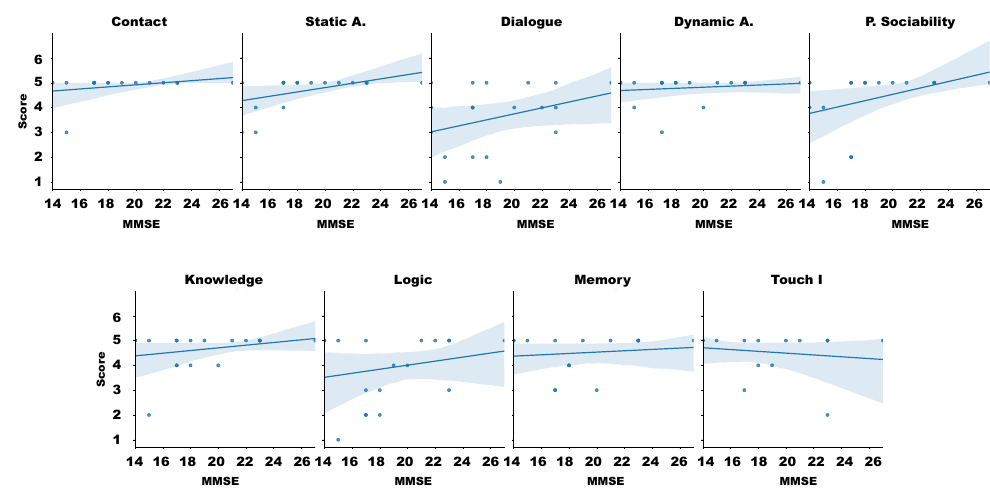
Figure 10. Correlation of Likert test and evaluation